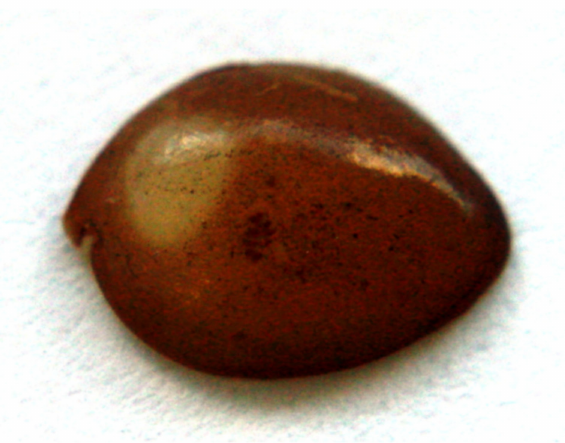
Figure 1. Macrocypridina castanea. Adult male, left carapace, 8 mm long. Anterior to the left. The region that covers the compound eye is visible as a ‘clear’, transparent oval shape (although has been stained by preservation solution). Reproduced from Parker et al. [6], with permission from The Royal Society,